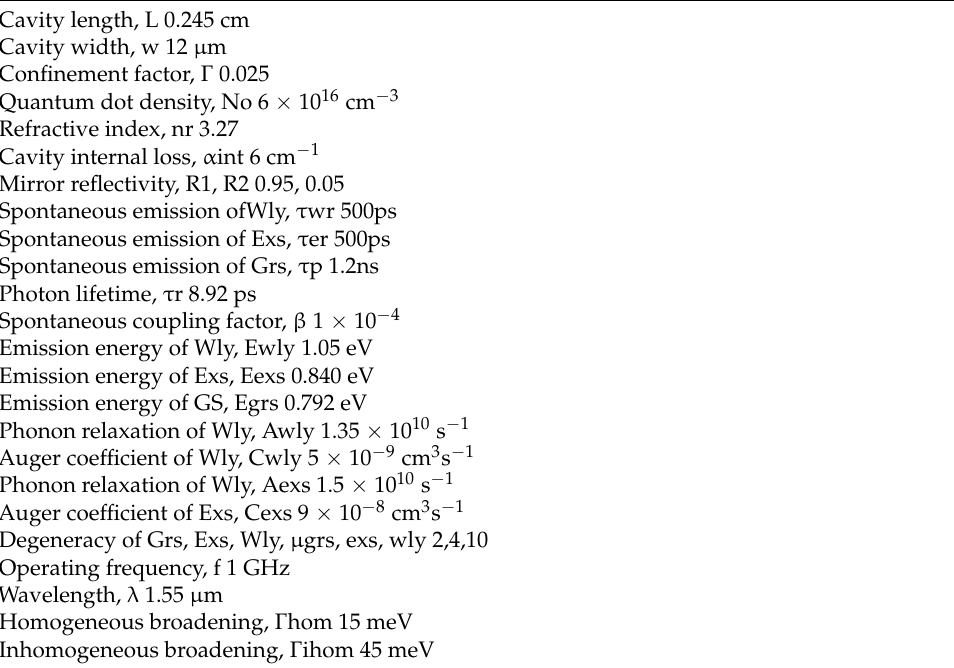
Table 1. Q-Dot laser